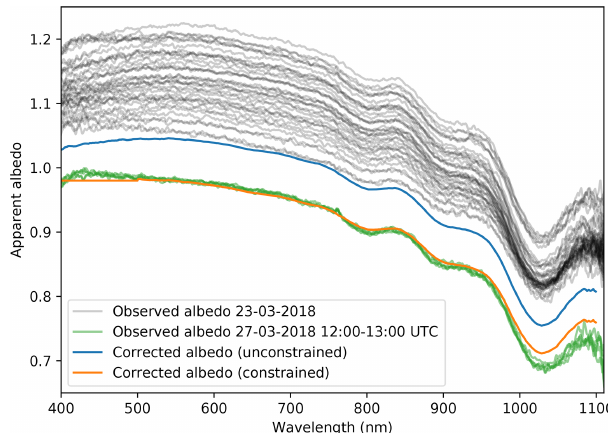
Figure 7. Albedo spectra measured with Autosolexs (grey) and cor- rected (orange, blue) on 23 March 2018. Measured albedo during overcast conditions on 2 March 2018 are also shown